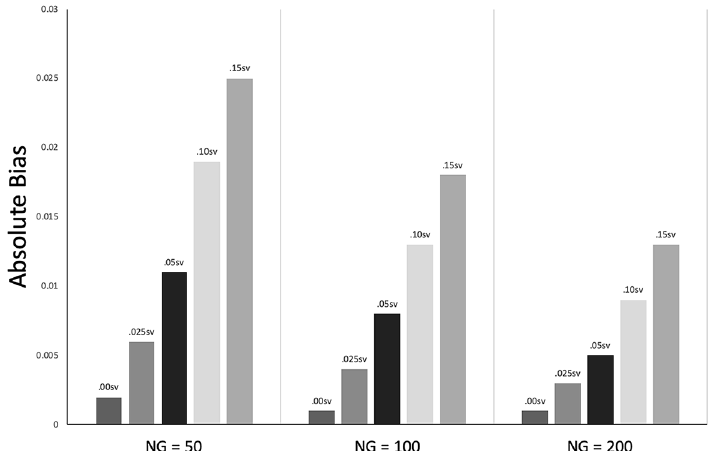
Absolute bias of the standard errors for γ 10 as a function of the amount of slope variance and number of